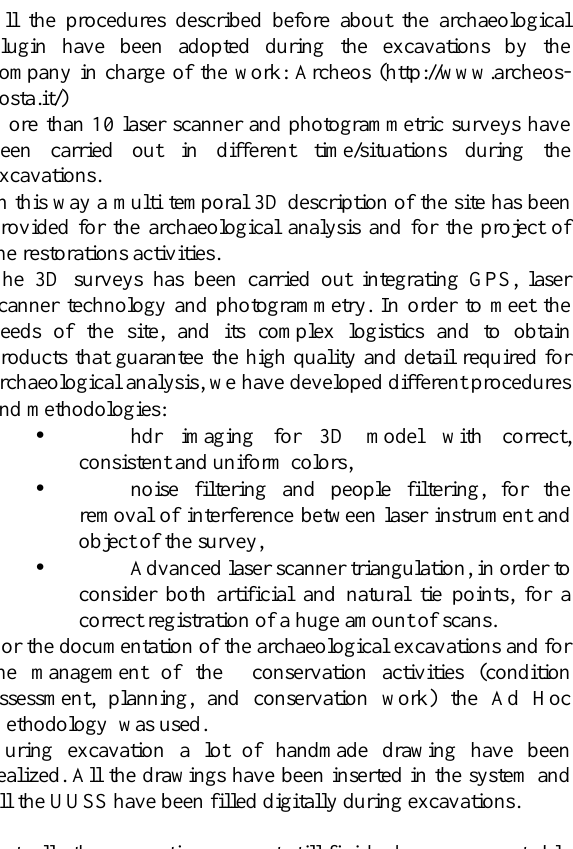
Figure 10. The “Porta Praetoria” in